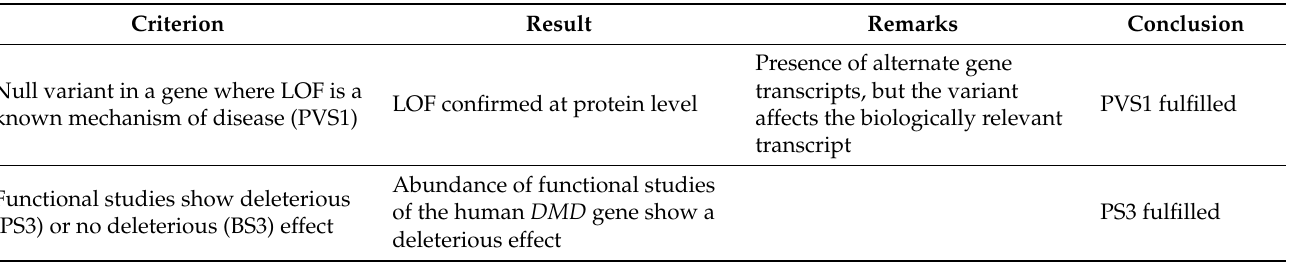
Table 1. Relevant criteria for variant classification.